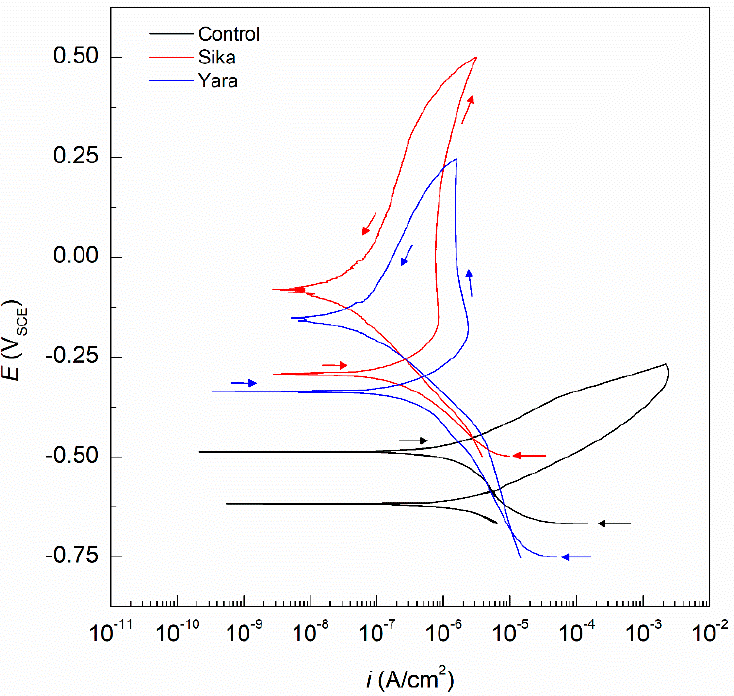
Figure 9. CPP curves obtained for steel rebars exposed to commercial corrosion inhibitor blends (Sika and Yara) in SCPS with 0.6 NaCl. Table 5. CPP parameters obtained for steel rebars exposed to commercial corrosion inhibitor blends (Sika and Yara) in SCPS with 0.6